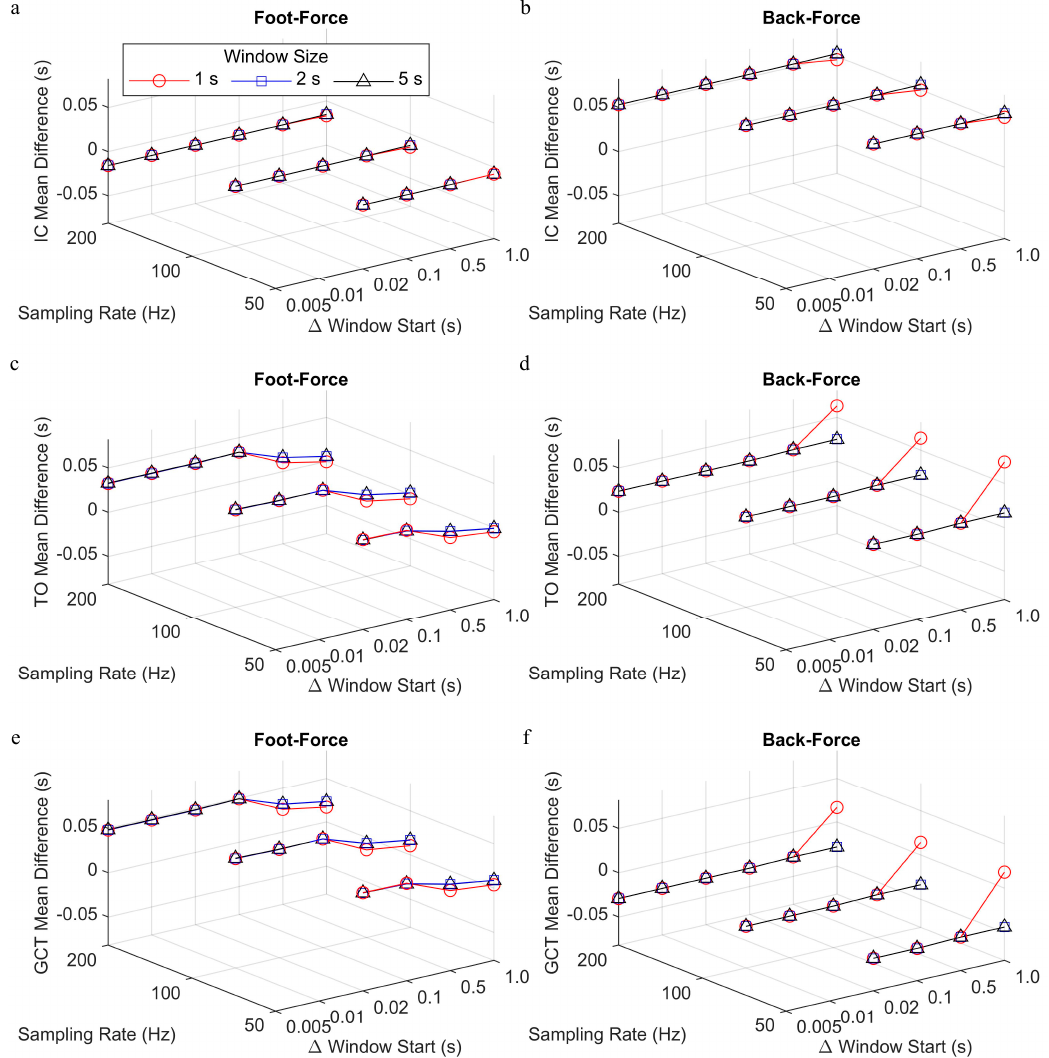
Figure 6. Mean difference between the accelerometer-based and force plate-based identification of initial contact (IC), toe off (TO), and ground contact time (GCT), processed with different sampling rate, window size, and change in window start time parameters. The difference is reported for ( a ) IC, foot-force comparison; ( b ) IC, back-force comparison; ( c ) TO, foot-force comparison; ( d ) TO, back-force comparison; ( e ) GCT, foot-force comparison; ( f ) GCT, back-force comparison.